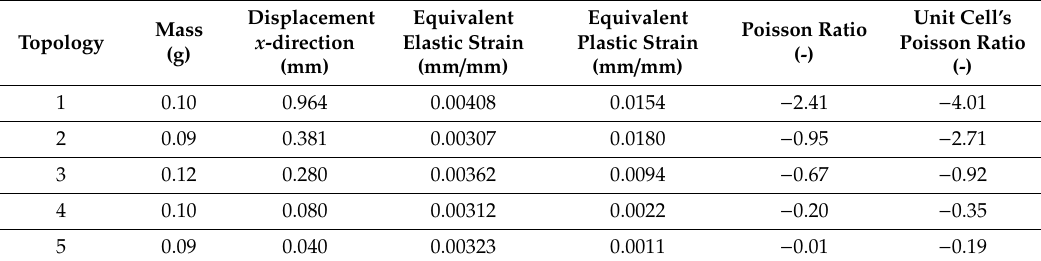
Figure 8. Deformed and undeformed structures. Table 3. Properties and results of the analysed